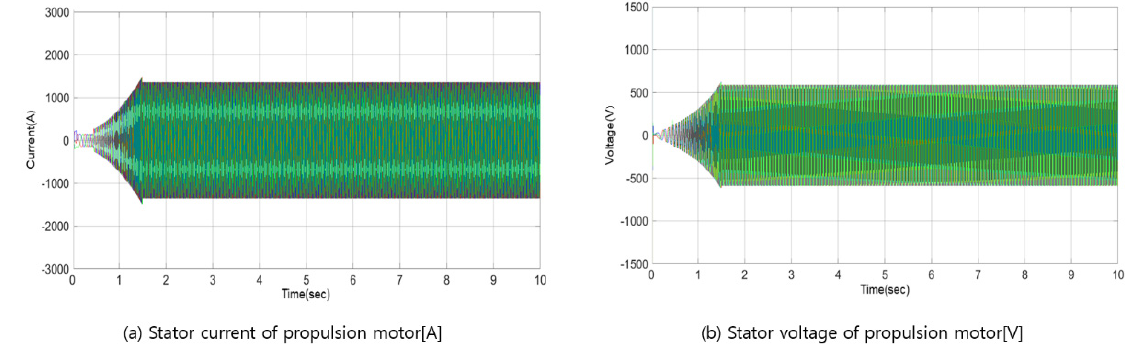
Figure 23. Simulation results of propulsion motor when load varies as 40 → 40%.